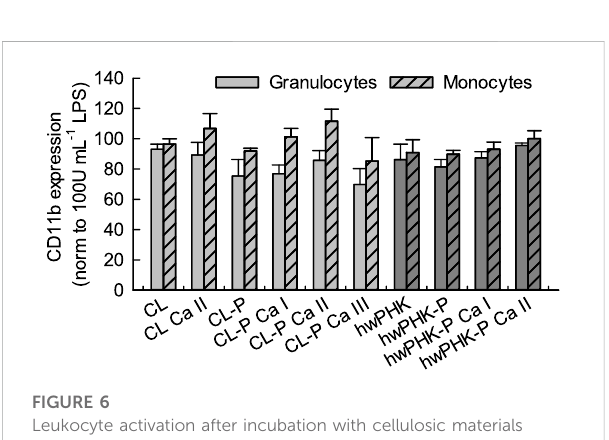
FIGURE 6 Leukocyte activation after incubation with cellulosic materials quanti fi ed by the expression of CD11b on leukocytes after incubation with whole